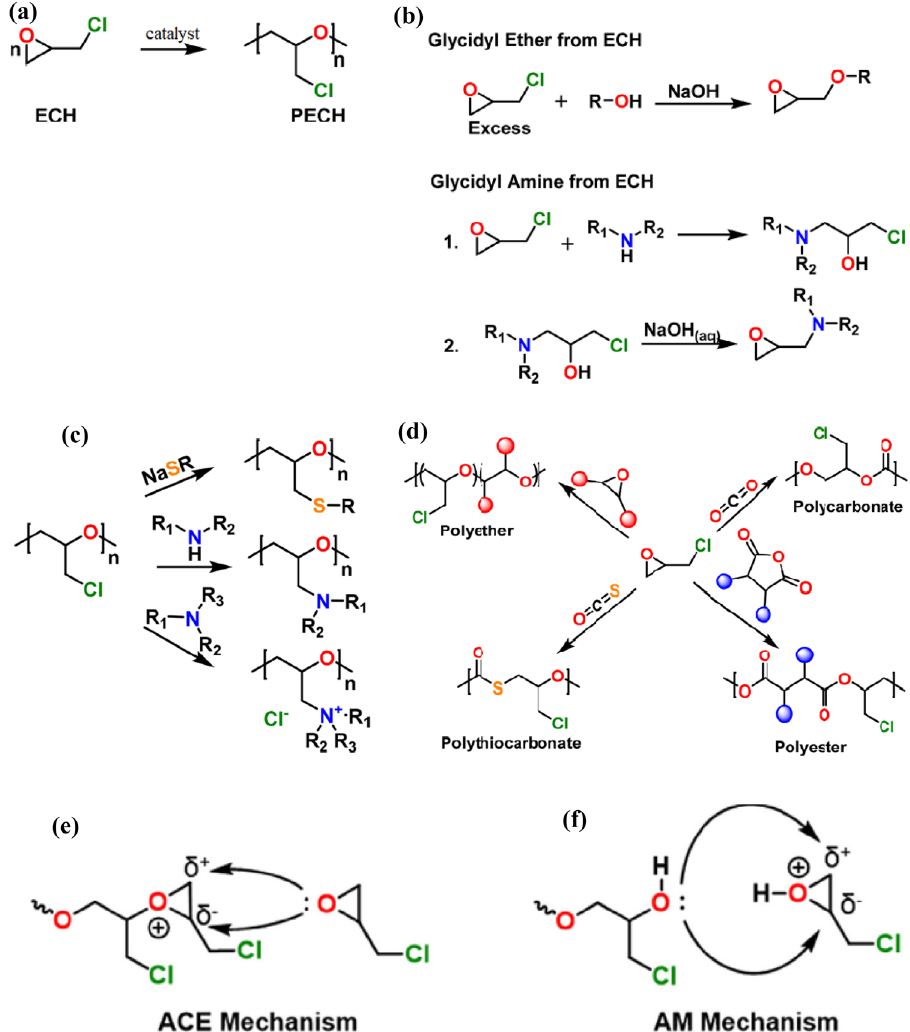
Fig. 3 a Synthesis of PECH, b synthesis of functional epoxides from ECH, c PECH post modification reactions, d copolymers based on ECH, e and f ROP mechanisms of ECH